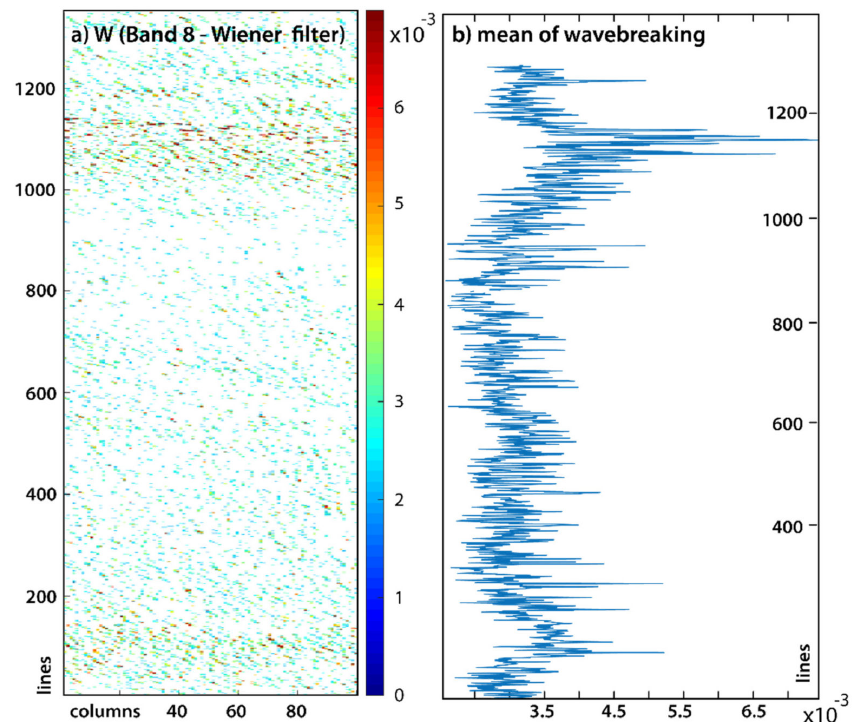
Figure 11. ( a ) W represents wave breaking as shown in Figure 10c but color-coded to highlight the ISWs’ different sections, in which we applied a threshold of 0.002 (see text for details). ( b ) Mean of wave breaking fraction, i.e., W calculated for each line of ( a ), which is also approximately along the ISWs’